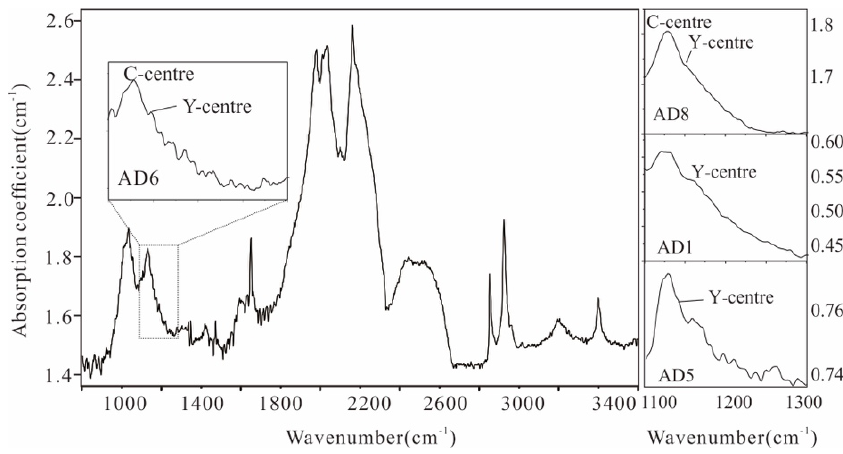
Figure 5. Y-centres in microdiamonds.